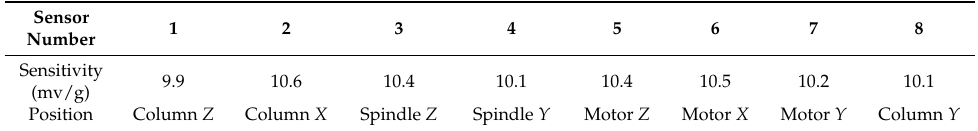
Table 4. The position of sensors and the corresponding sensitivities.